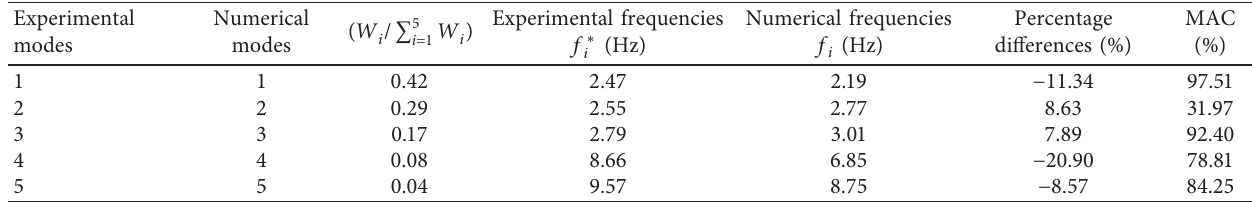
Table 9: Results of the modal decomposition analysis from the model without the underground story, assuming w / d � 0.24, and comparison with experimental outcomes.